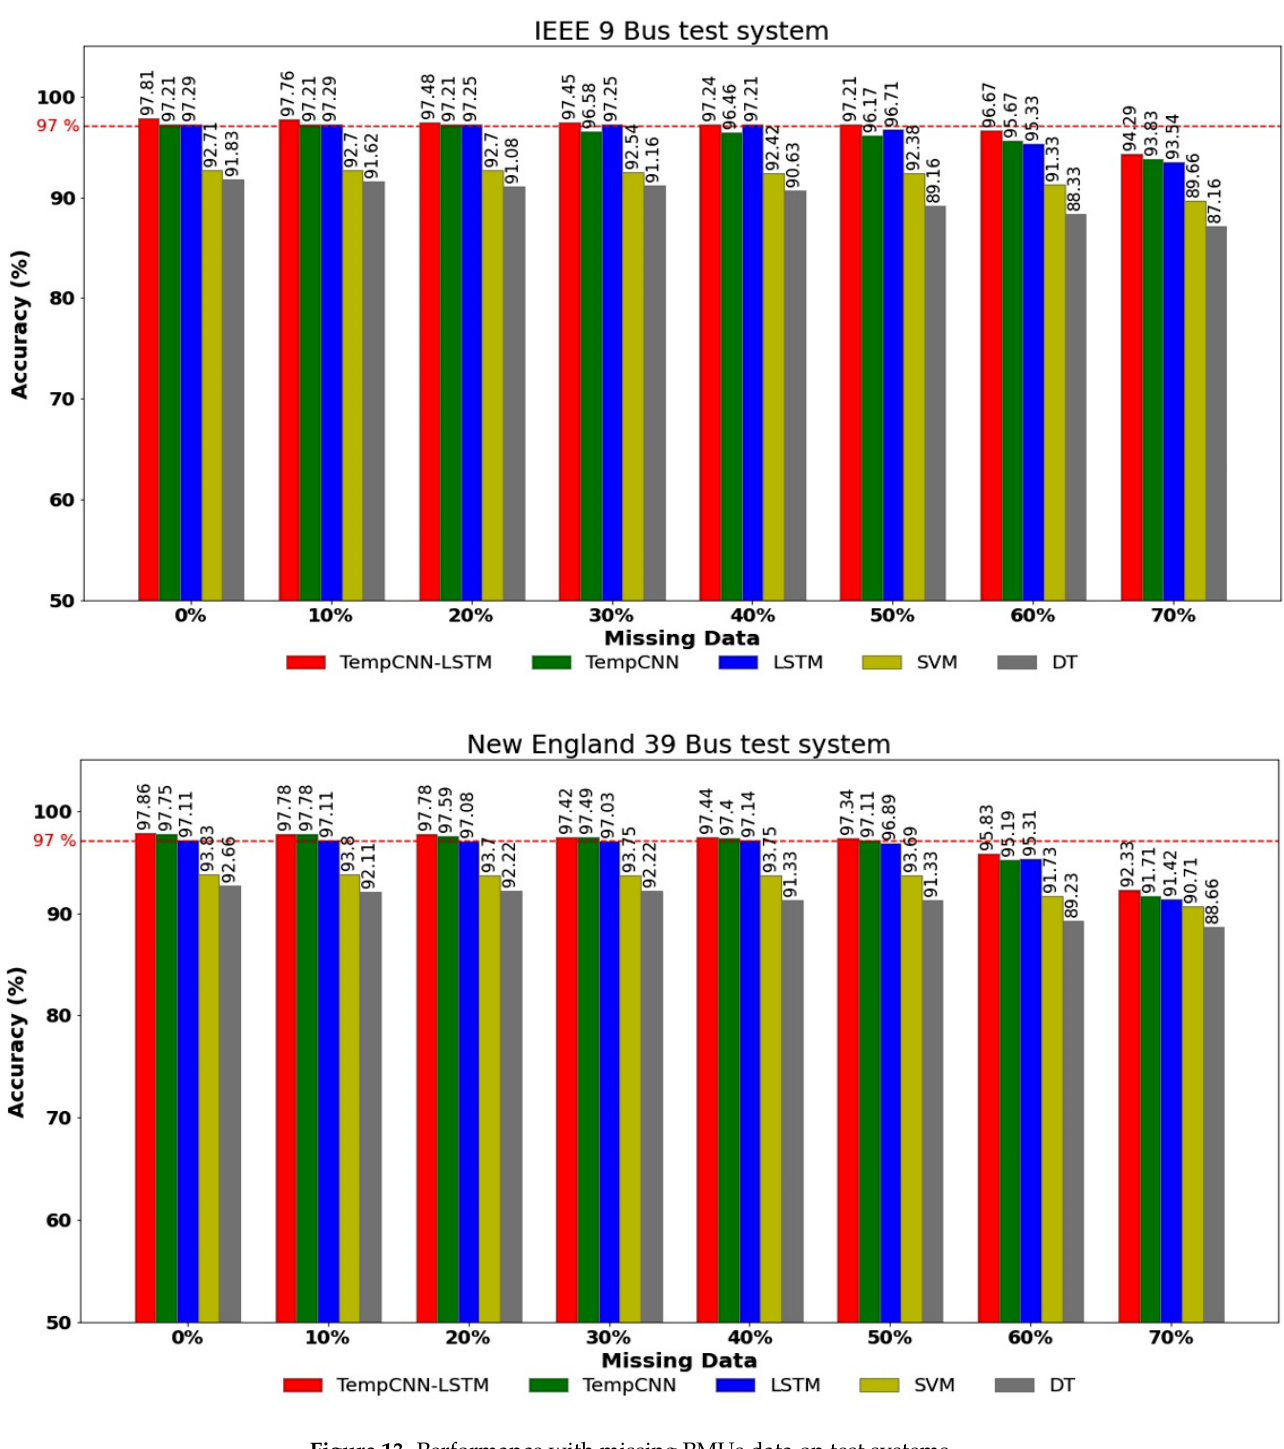
Figure 13. Performance with missing PMUs data on test